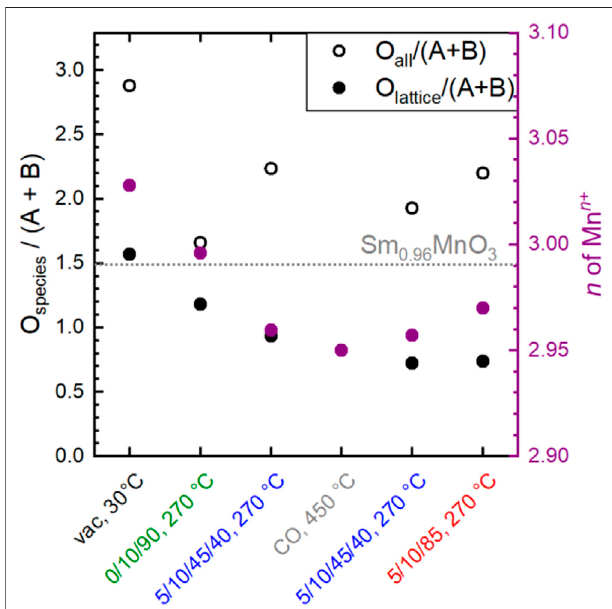
FIGURE 11 | The ratio of the sum of all fi tted oxygen (O all ) species and the sum of Mn + Sm obtained from XPS analysis (empty circles) in dependence on conditions applied and the ratio of the amount of O lattice and the sum of Mn + Sm obtained from XPS analysis (full circles) in dependence on conditions applied. Purple full circles depict the Mn oxidation state obtained from Mn L-edge fi tting. C 3 H 8 /O 2 /inert (cid:2) 5/10/85 (dry); C 3 H 8 / O 2 /inert/H 2 O (cid:2) 5/10/45/40 (wet). The dotted line represents the number from bulk analysis for comparison (XRF and O